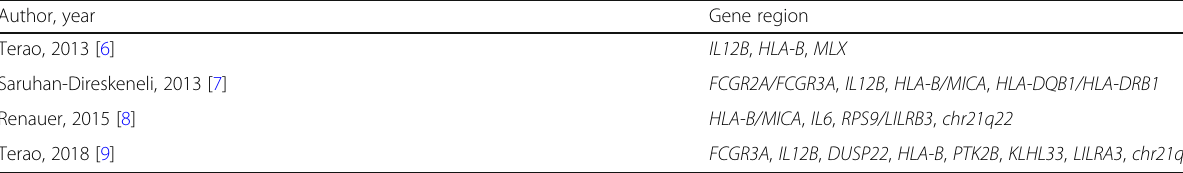
Table 1 Gene regions associated with TAK Author,